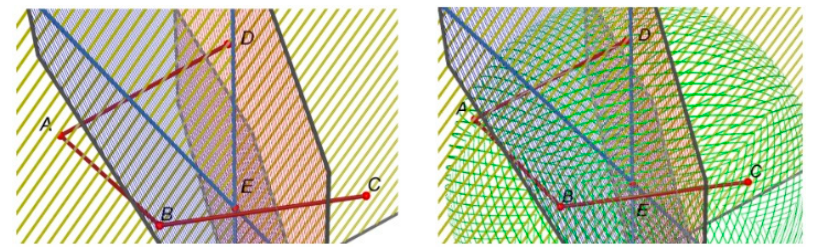
Figure 10. Dynamic diagram of problem 2 solution in 3D domain.